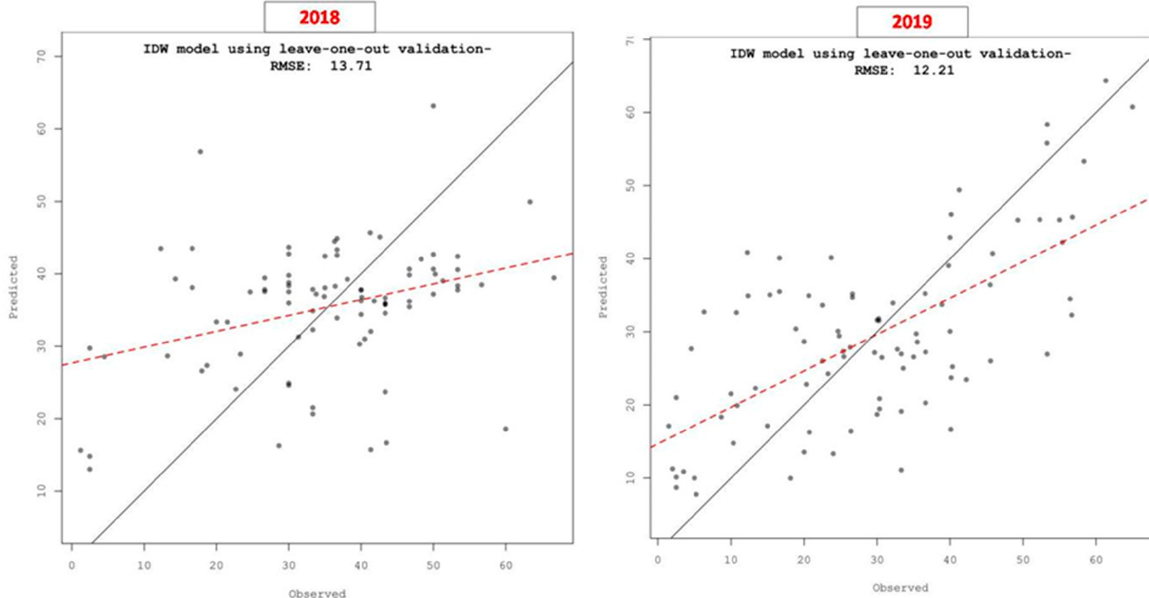
Figure 6. Scatter plot pitting predicted values vs. observed values at each sampled location for FRD in Karnataka following a leave-one-out cross-validation analysis.